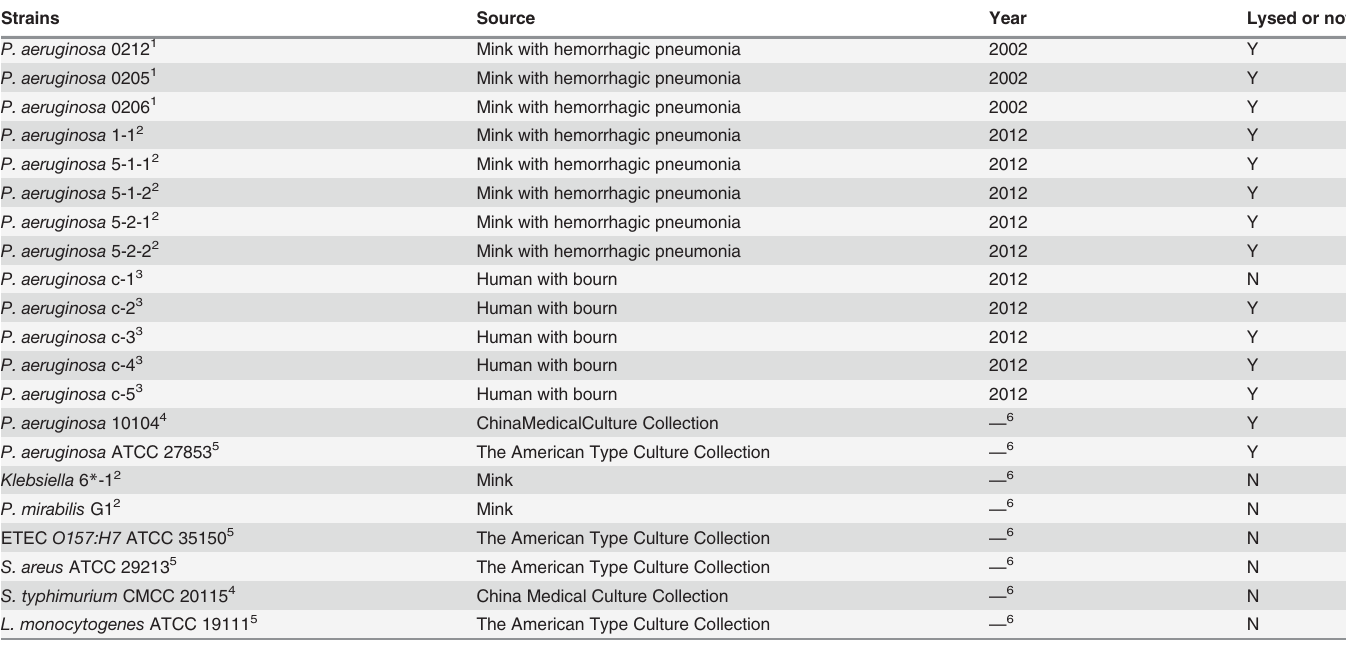
Table 1. Bacterial stains used to determine the host range of phage